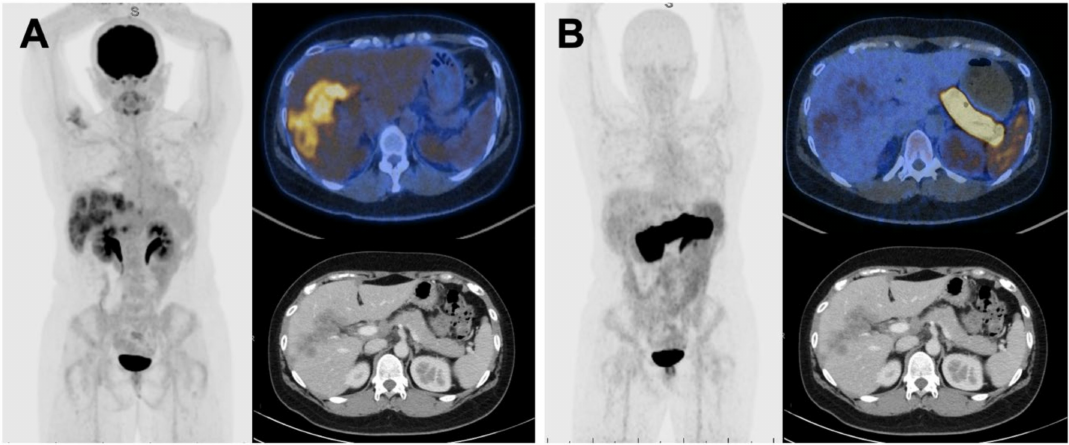
Figure 2. MIP and axial slices of [ 18 F]FDG PET-CT ( A ) compared to 1 h [ 64 Cu]Cu-SAR-BBN ( B ) in Patient 6. Diagnostic CT shows hypoenhancing liver metastases, confirmed by biopsy. These lesions were FDG positive, BBN